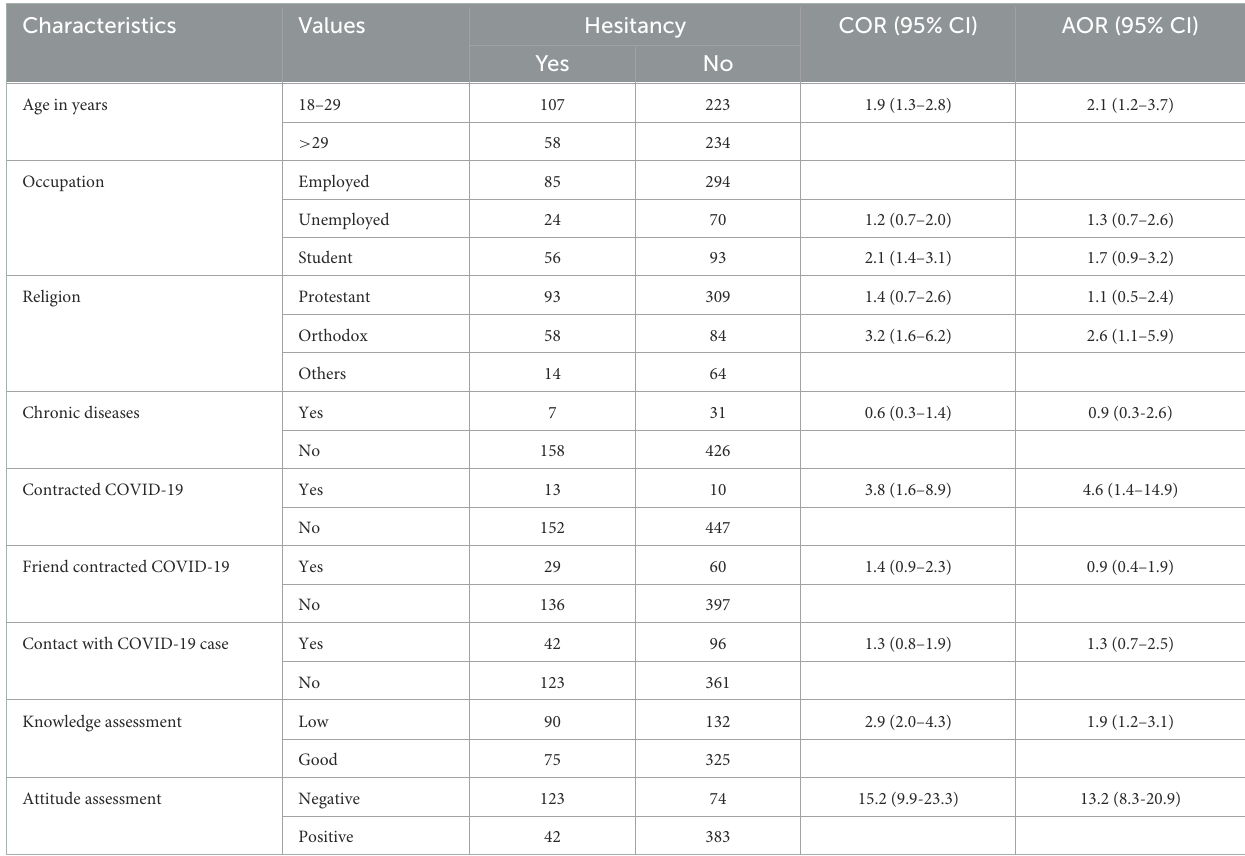
TABLE 4 Factors affecting COVID-19 vaccine hesitancy among adults in Hawassa City.